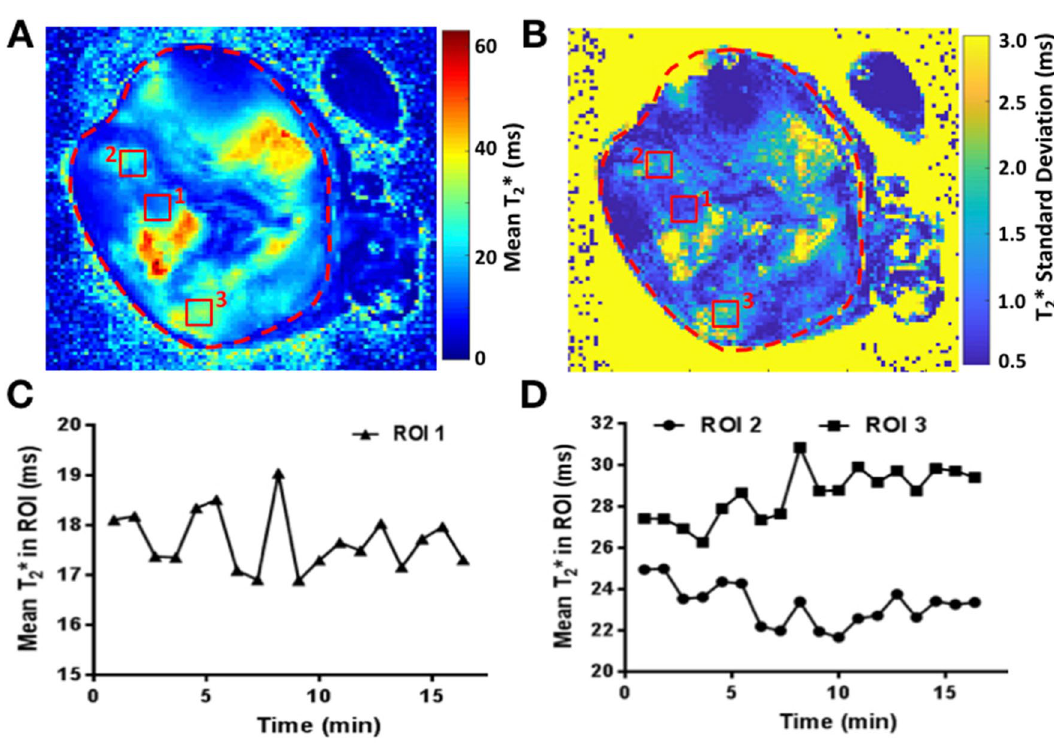
Figure 5. Oxygen fluctuations in vivo. ( A ) Mean T2* value and ( B ) standard deviation of the T2* changes in time are shown for a representative slice. Small regions of interest, marked with red rectangles, were drawn to illustrate distinct temporal T2* kinetics in tumor, plotted in ( C ) (ROI 1) and D (ROI 2s and